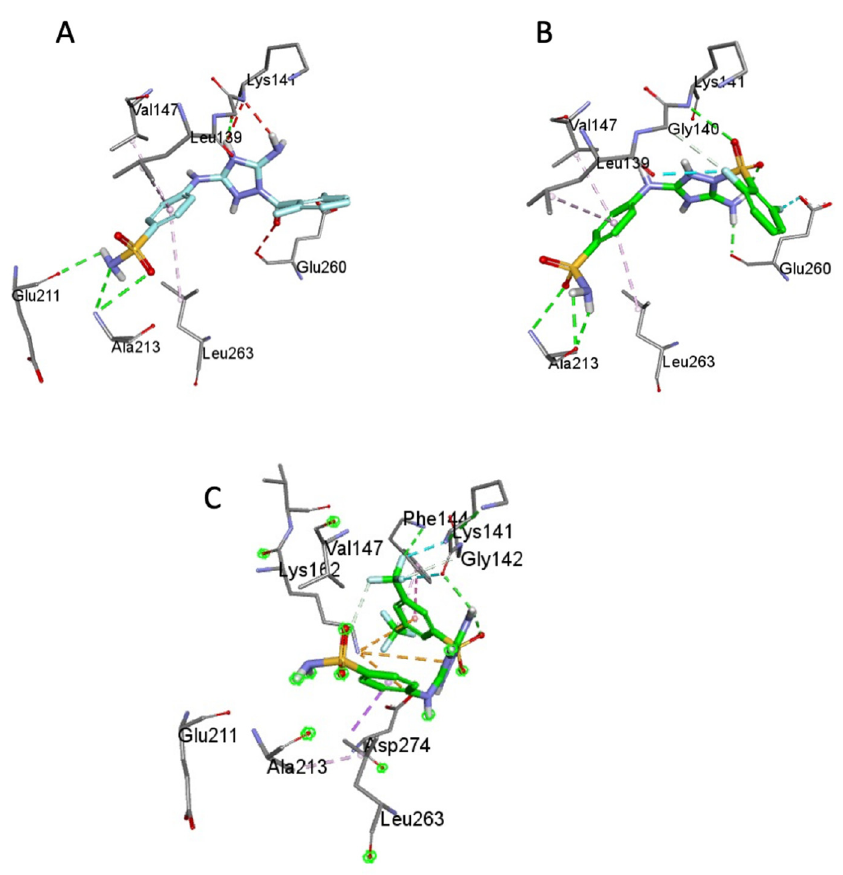
Figure 3. The molecular interactions of JNJ-7706621 ( A ), 1b ( B ) and 1d ( C ) with the ATP-binding site of Aurora-A kinase (PDB ID: